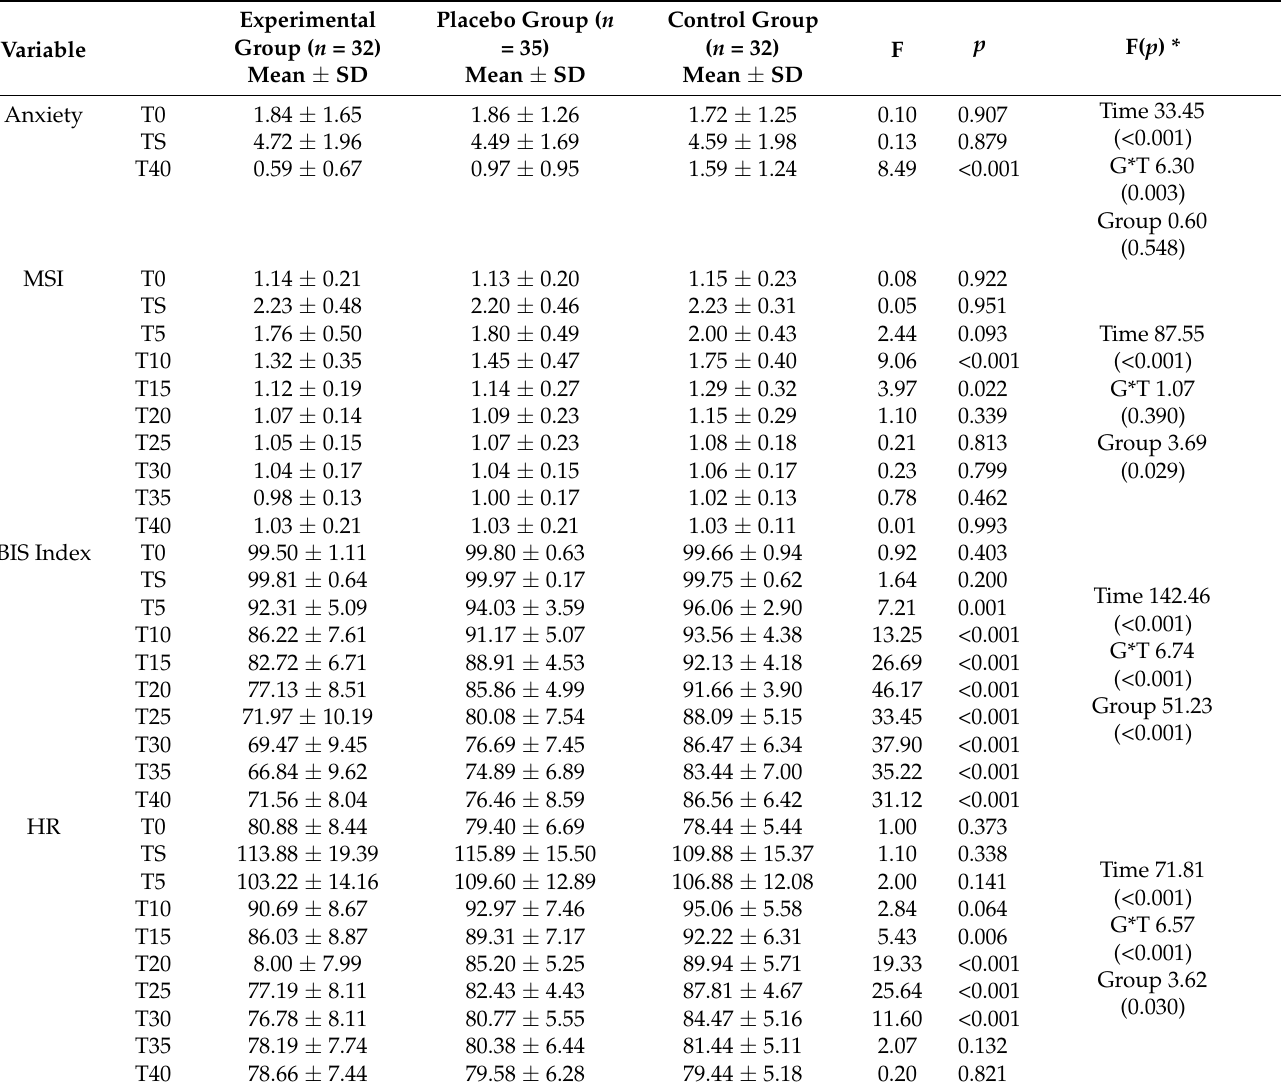
Table 2. Comparison of anxiety, autonomy nerve balance, BIS index, and heart rate of the experimental, placebo, and control